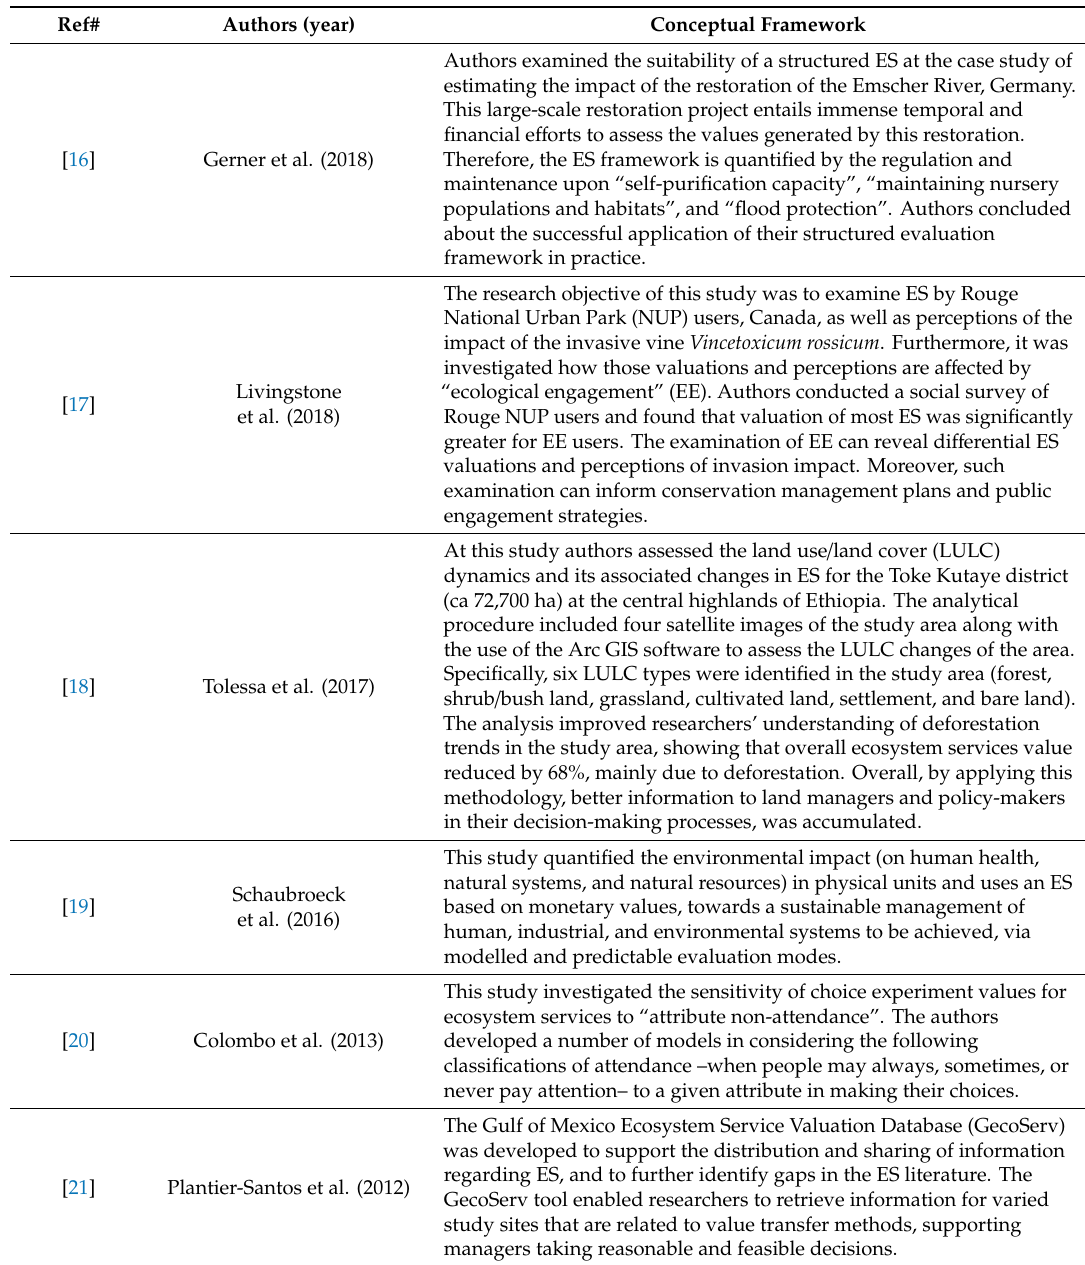
Table 1. Literature overview of ES under the thematic classification of “sustainable provision and modeling